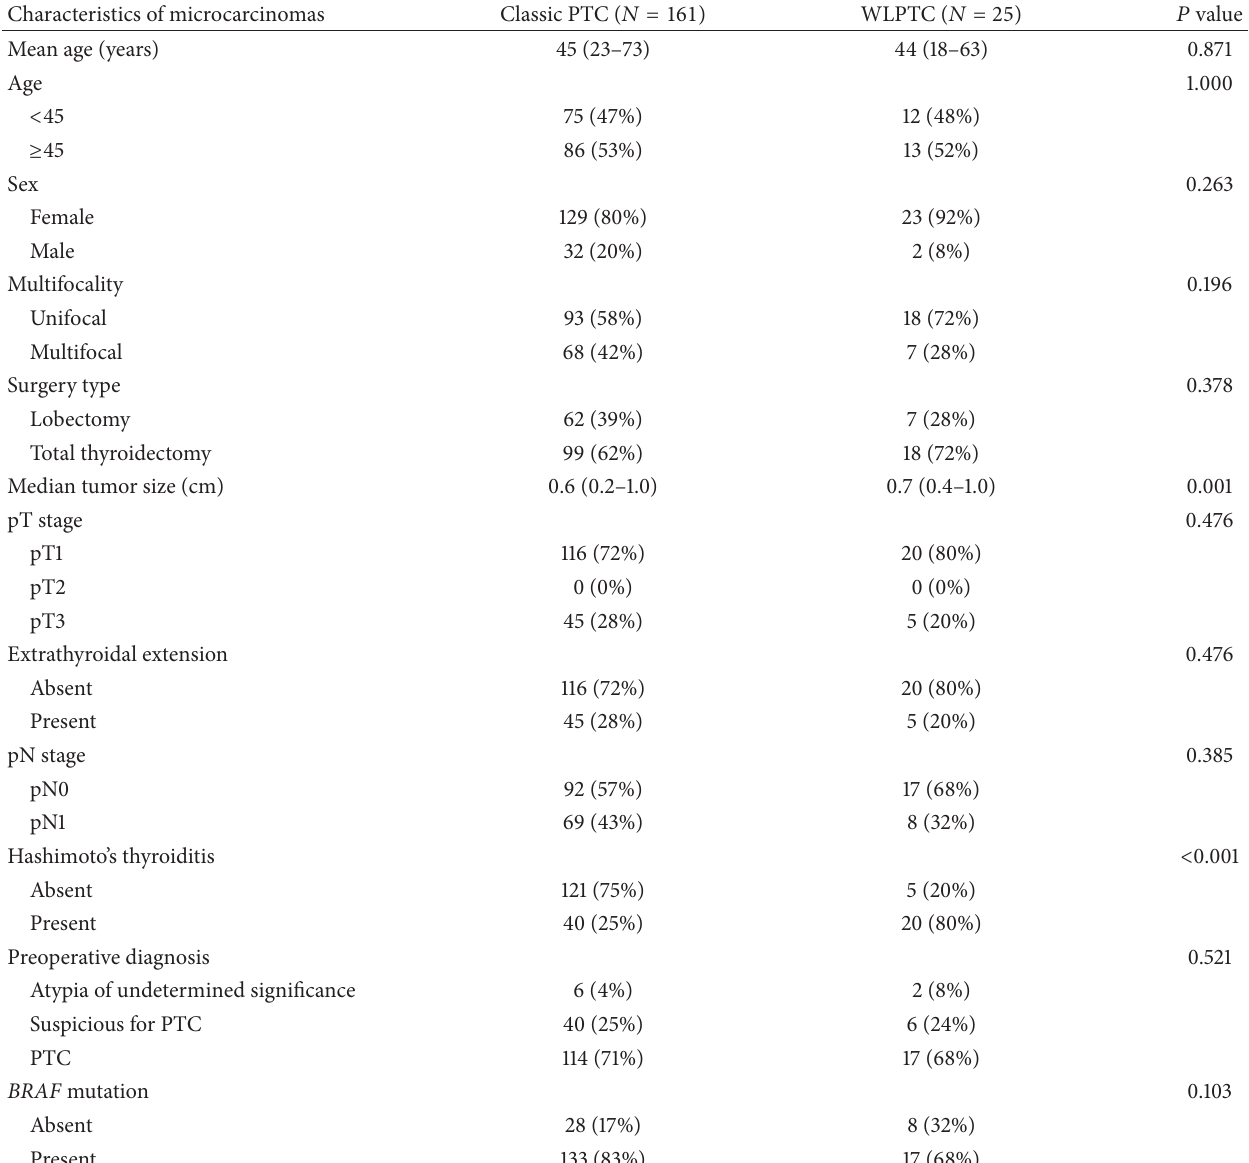
Table 4: Comparison of clinicopathologic characteristics between WLPTC and classic PTC microcarcinomas ( ≤ 1cm). Characteristics of